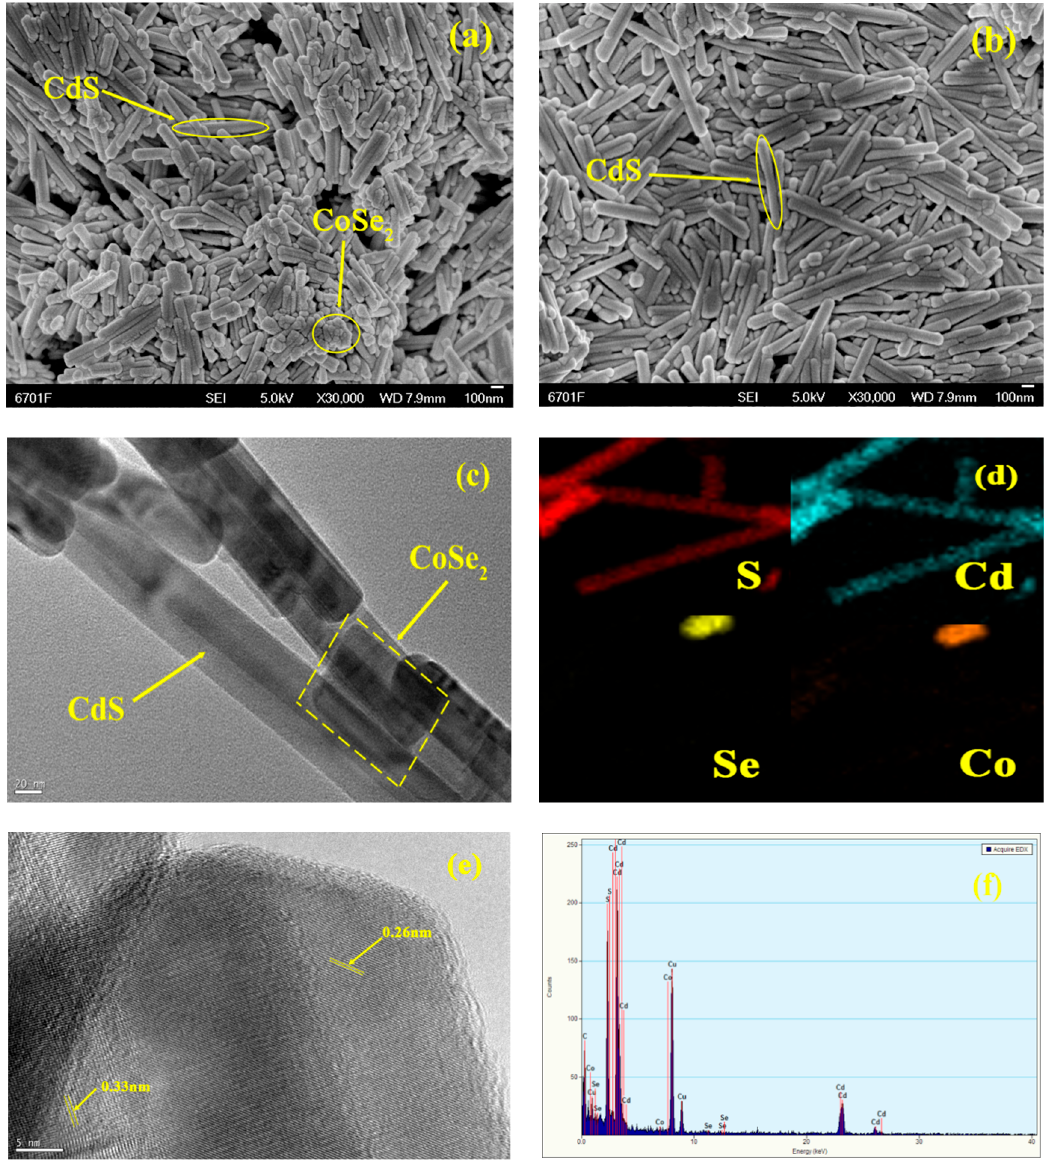
Figure 1. SEM and TEM pattern of sample: ( a ) SEM pattern of CoSe 2 / CdS; ( b ) SEM pattern of pure CdS; ( c ) TEM pattern of 30% CoSe 2 / CdS; ( d ) element mapping of CoSe 2 / CdS; ( e ) the HRTEM of CoSe 2 / CdS sample; and ( f ) EDX pattern of CoSe 2 /CdS.